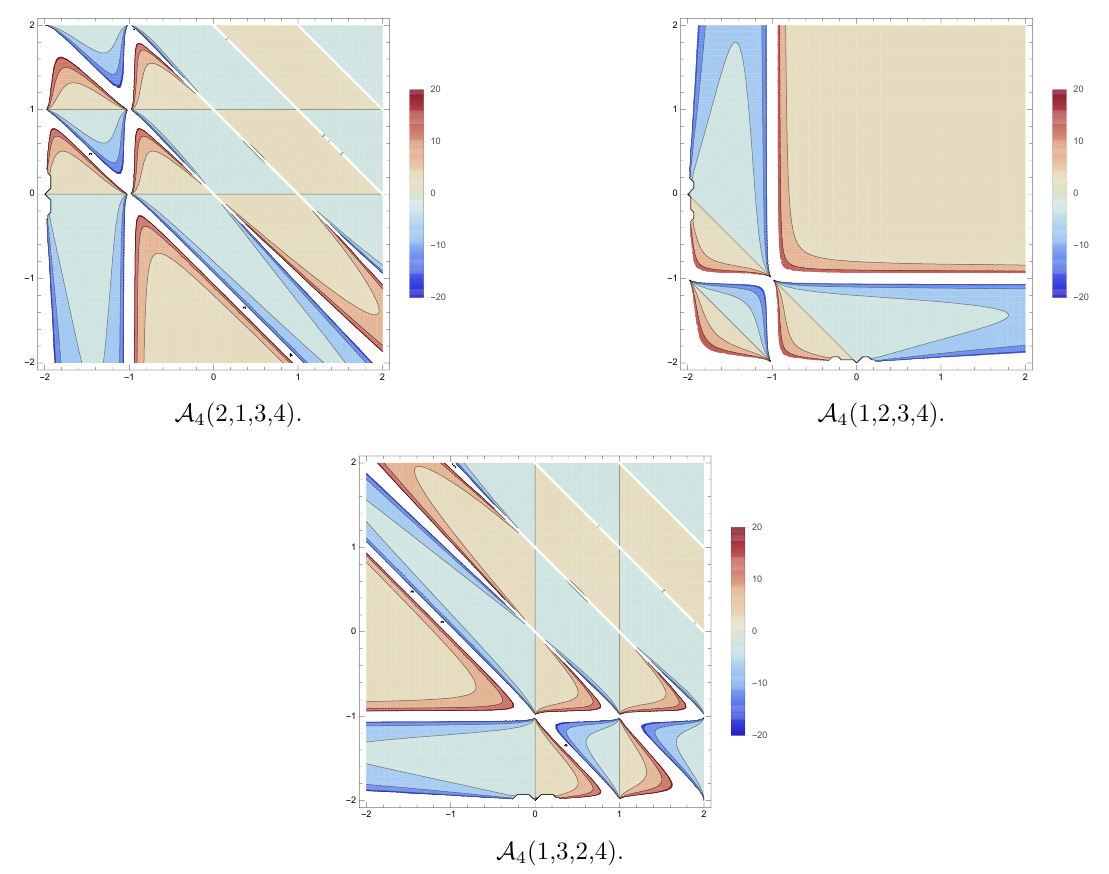
Figure 3. Contour plots for three partial open tachyon amplitudes with 2 α 0 k 1 · k 2 and 2 α 0 k 2 · k 3 being X-axis and